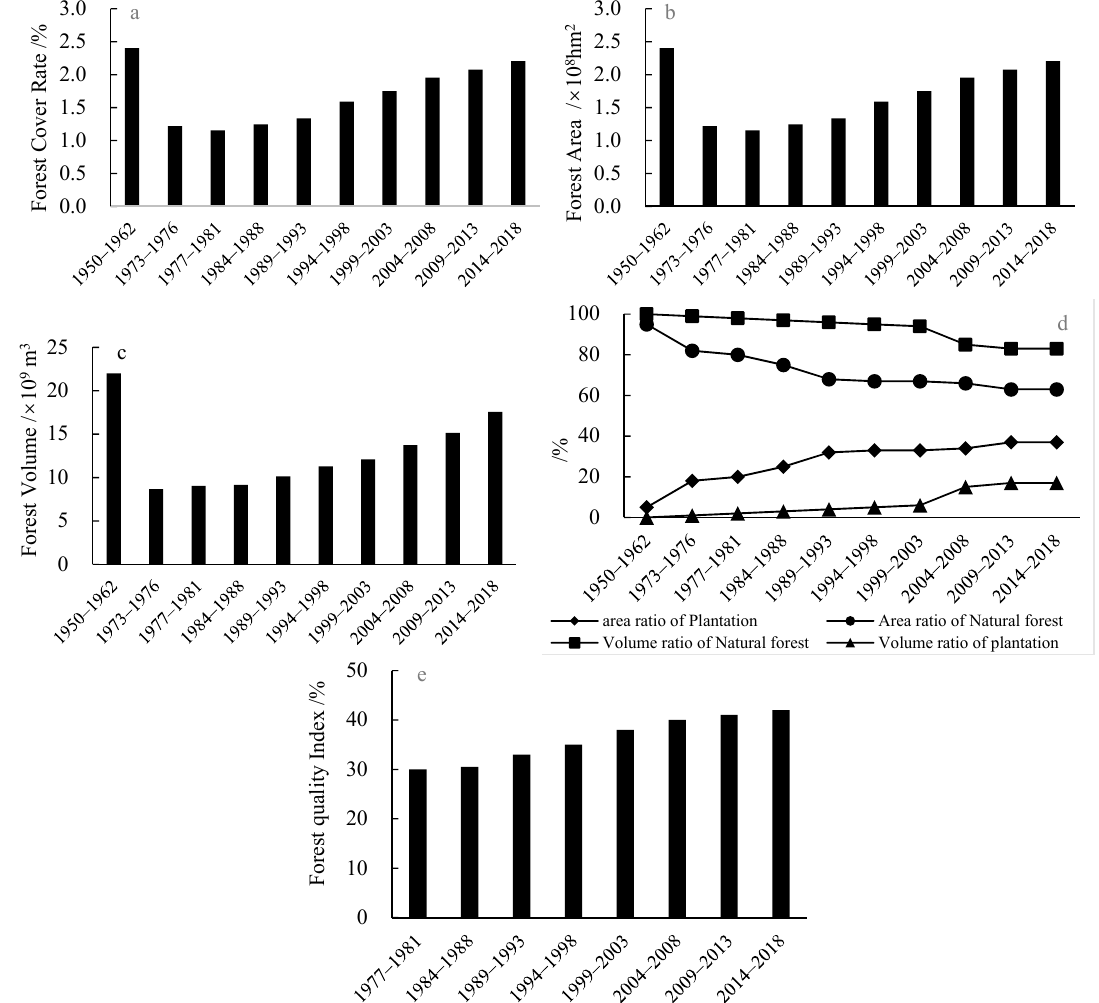
Figure 1. The trends of forest area and forest quality in China from 1950–2018. (( a ) is the forest cover rate, ( b ) is the forest area, ( c ) is the forest volume, ( d ) is the origin structure, and ( e ) is the forest quality